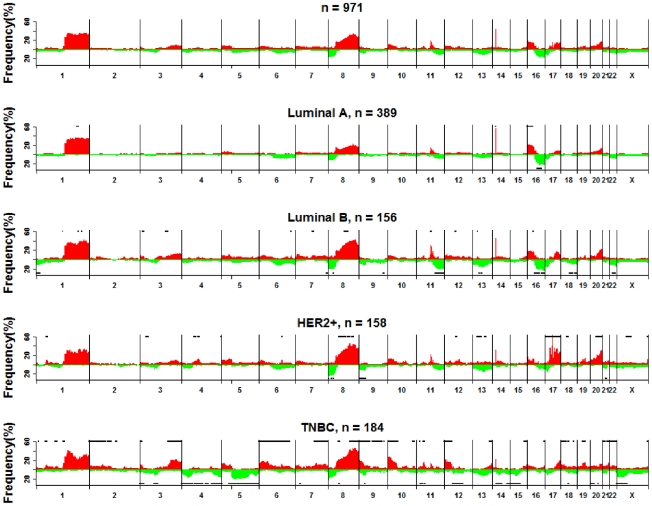
The five panels show the percentage of samples showing gain (red) or loss (green) for all 971 tumors (top) and individually for each clinical subtype.The horizontal black lines at the top (and bottom) of a panel associated with a particular clinical subtype indicate regions showing statistically significant increase in gain (and loss) frequencies (FDR<0.01) for this subtype compared with the other subtypes.